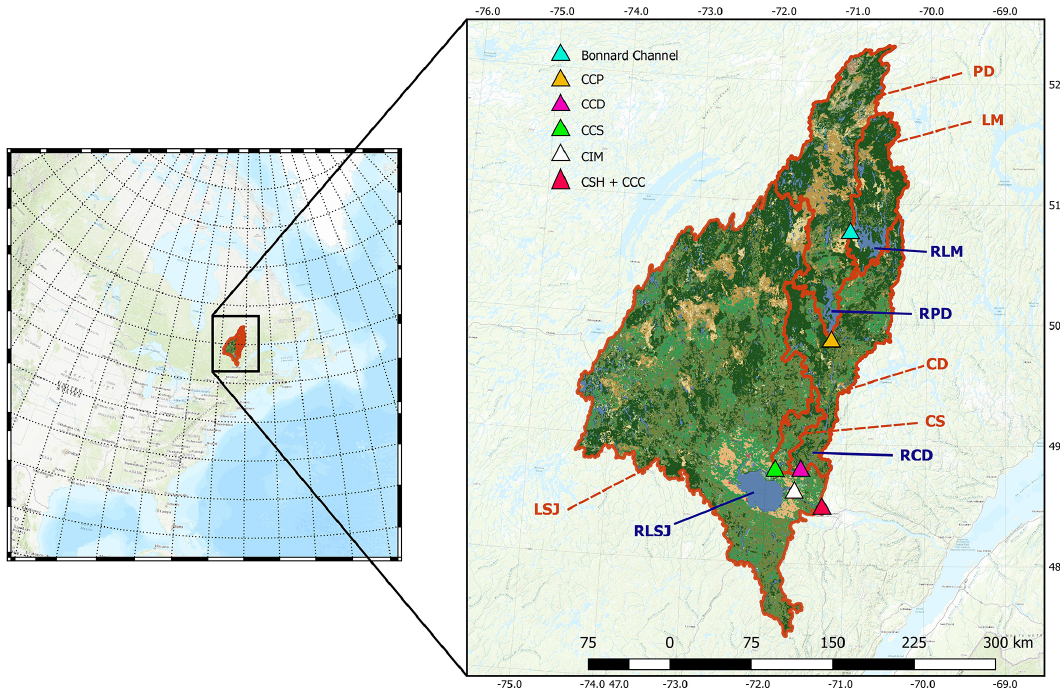
Figure 1. Study area location, hydropower generating stations and reservoirs. Table 1. Generating station and reservoir characteristics in the SLSJ hydroelectric